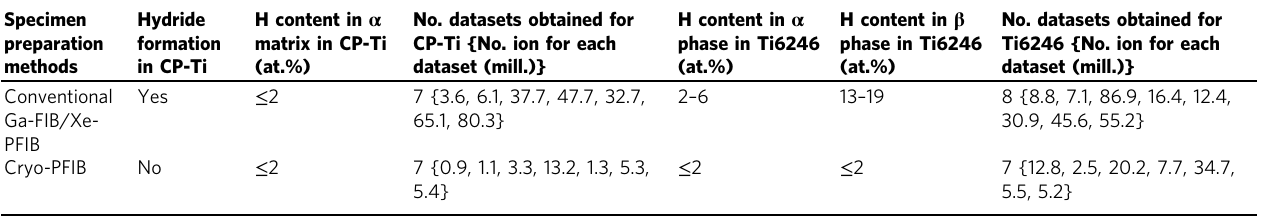
We show atom probe tomography (APT) results of hydride visibility and the average H amount (at. %) detected in the matrix α and/or β phase of CP-Ti and Ti6246 alloy. All data obtained in high- voltage mode. The number of measured specimens and the number of ions (in millions) run in each specimen are